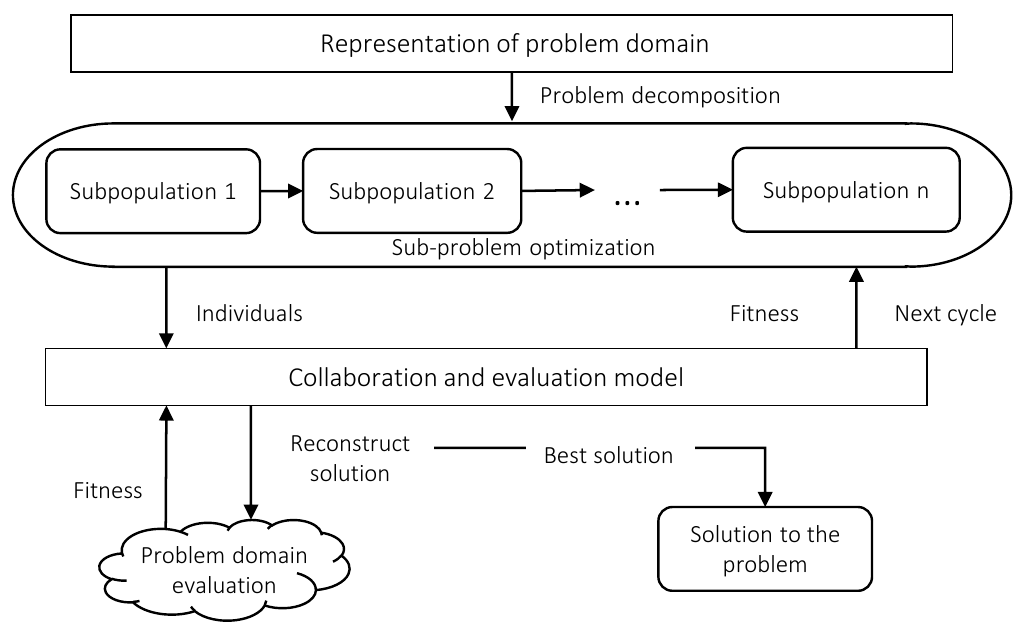
Figure 3. A general architecture of cooperative co-evolutionary algorithm